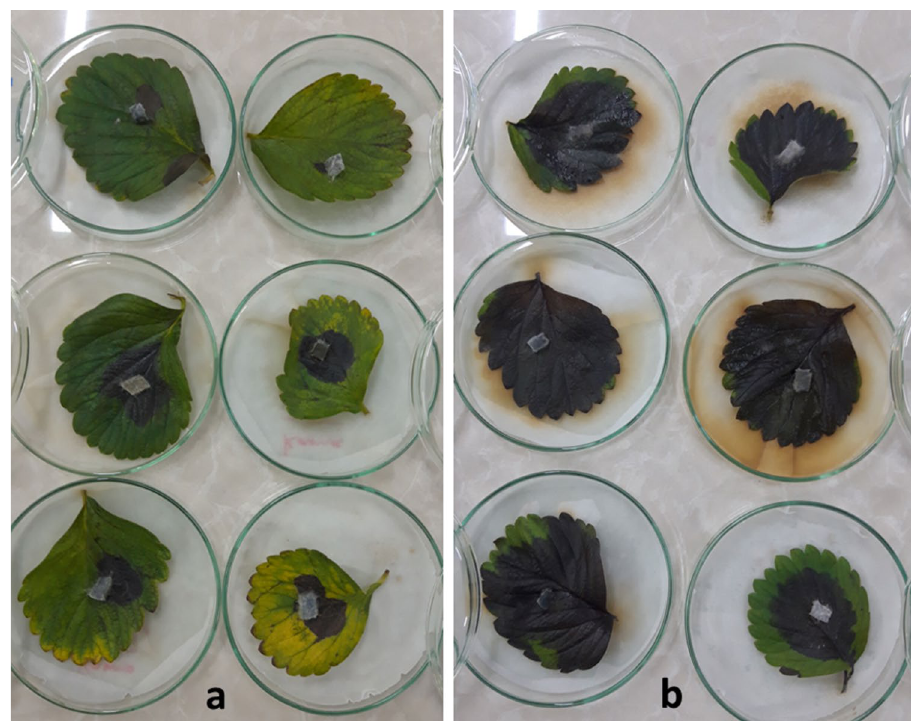
Figure 2. Bioassay of pFGC-TEF-d efficiency in the transient expression on L. theobromae in strawberry leaves (Camarosa) at 7 dpi. ( a ) Leaves transiently expressed pFGC-TEF-d as a treatment and ( b ) control leaves expressing empty plasmid ( pFGC